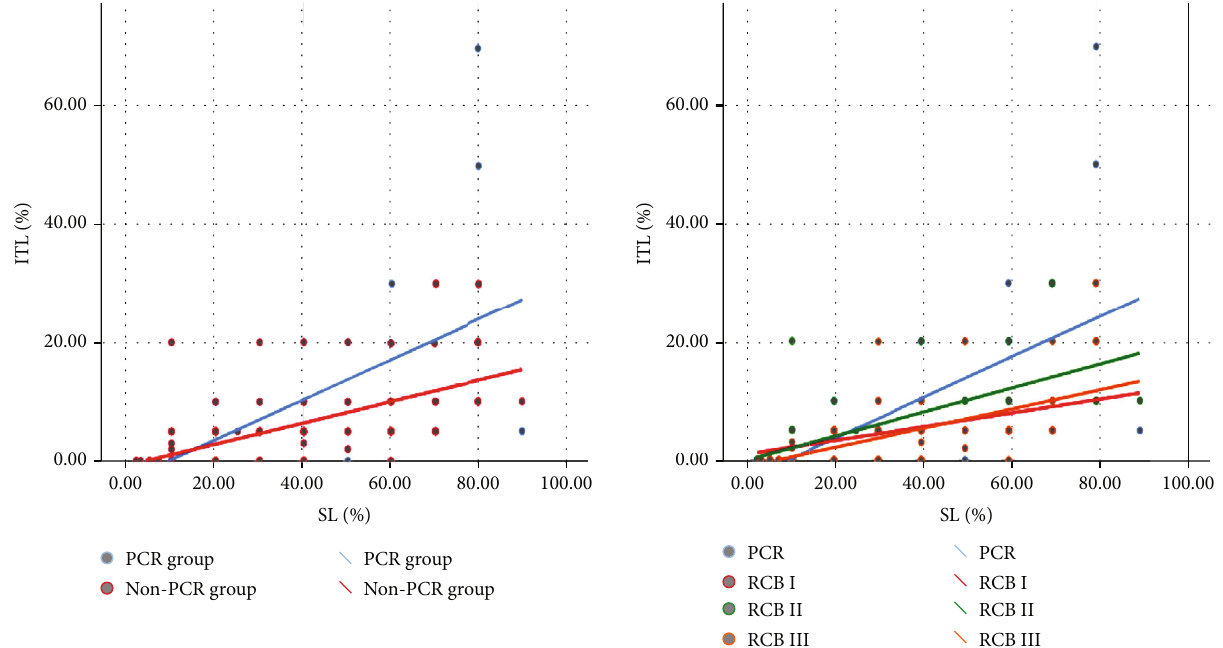
Figure 2: Correlation between ITL and SL using Spearman correlation coe ffi